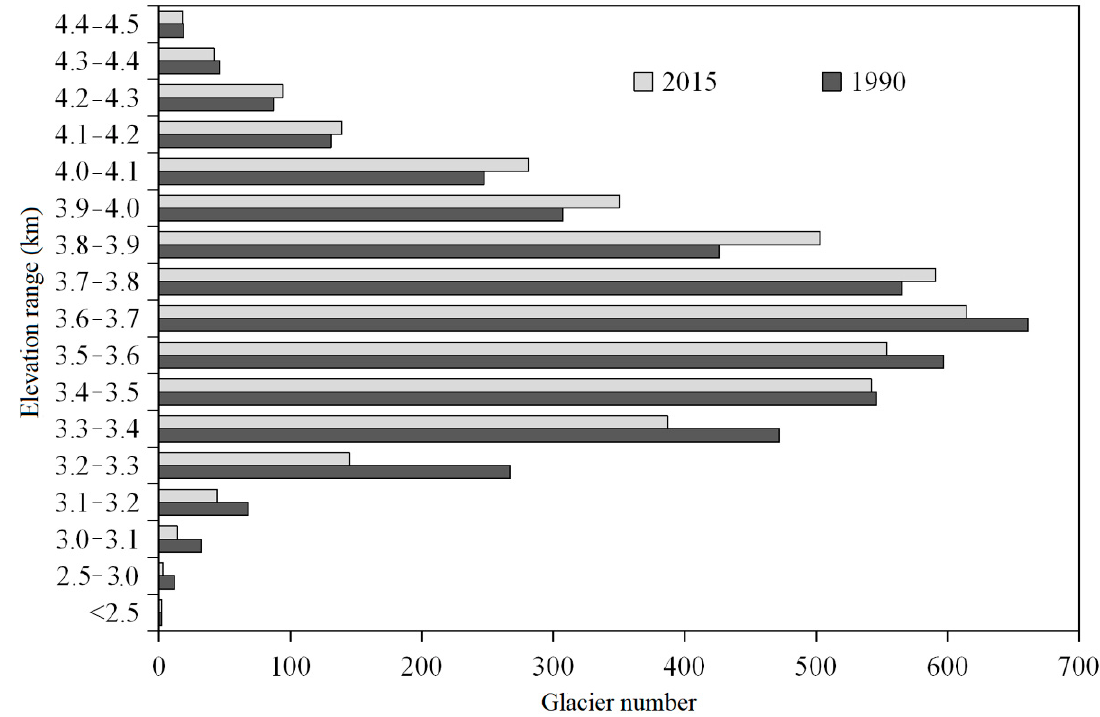
Figure 9. Glacier numbers at different altitudes in 1990 and 2015.